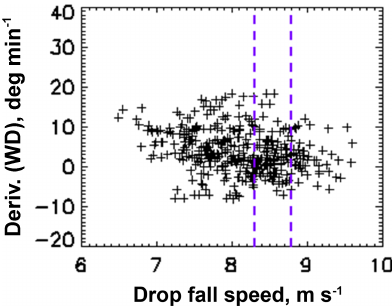
Figure 4. Variation of drop fall speeds with apparent axis ratios for the 3mm drops corresponding to Fig. 3b. Shown in dotted purple and red lines are the expected fall speed and axis ratio.